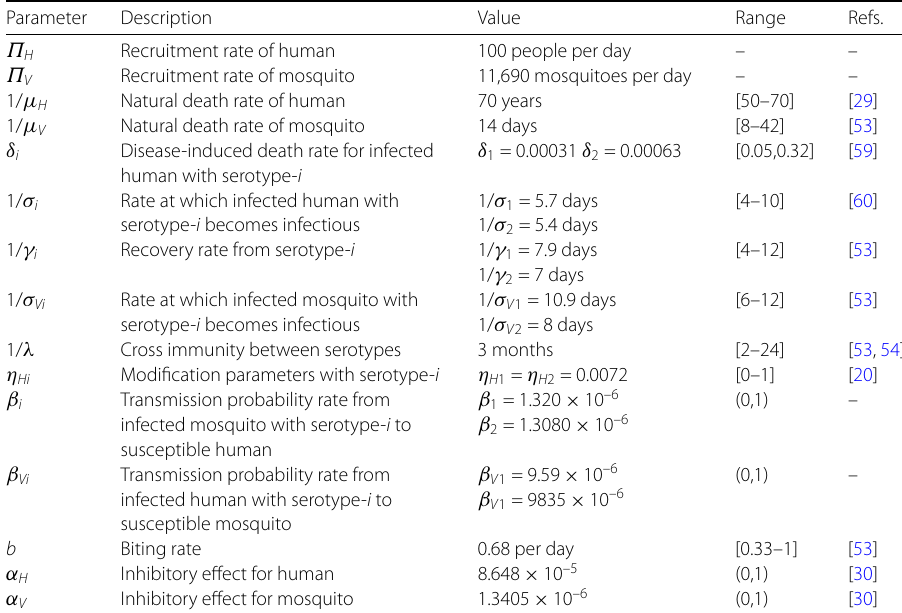
Table 2 Description of parameters and values used for the multi-serotype dengue model (2.4)–(2.5) Parameter